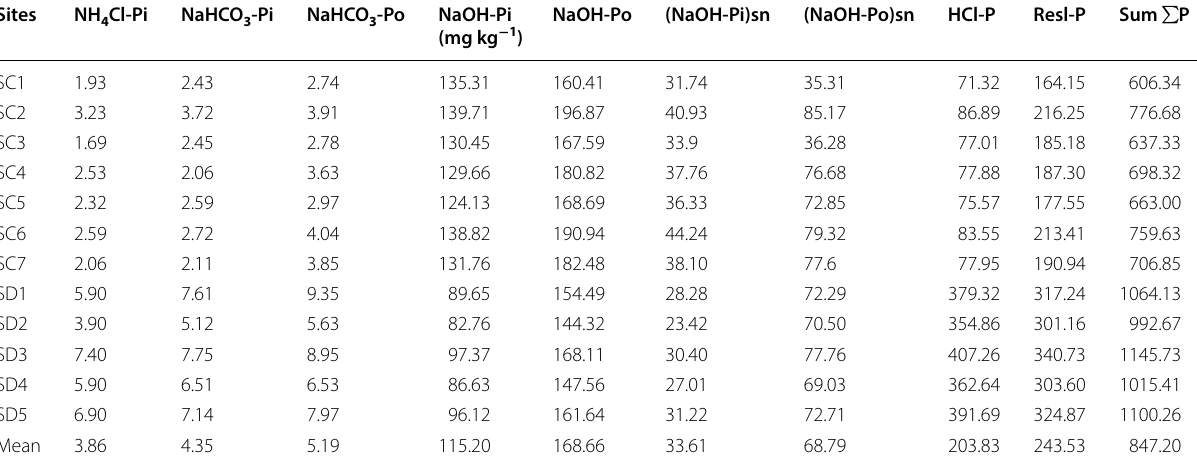
Table 6 Inorganic and organic P fractions and their